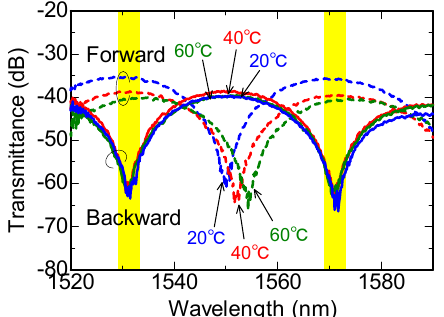
Figure 7. Measured transmission spectra of the fabricated MZI isolator designed for temperature-insensitive operation.